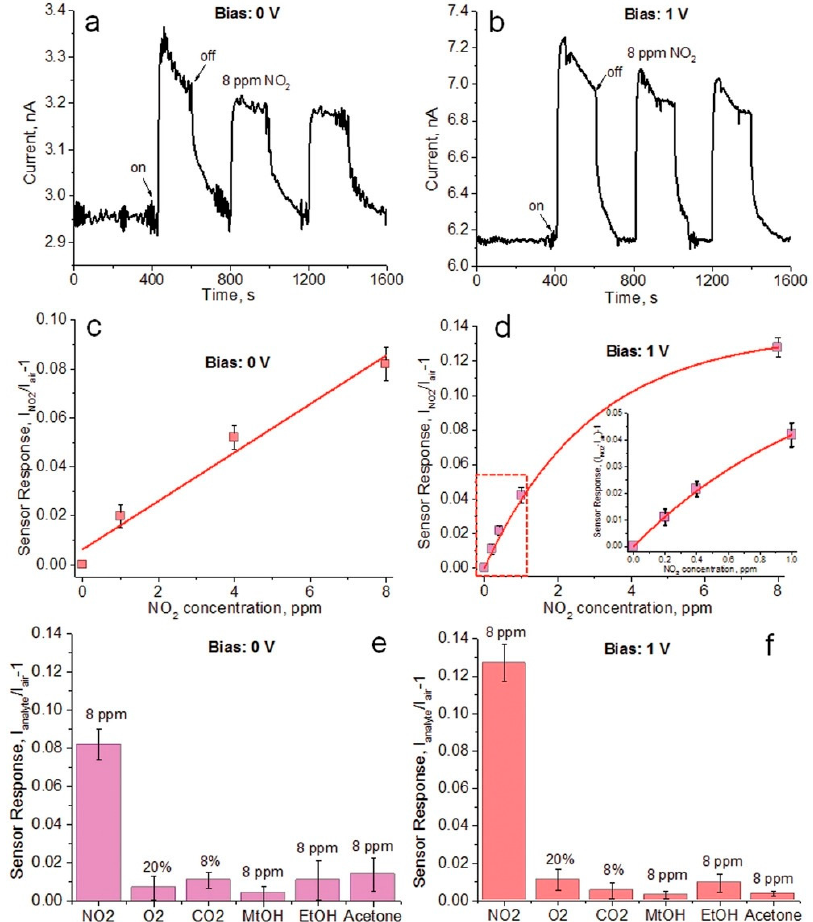
Figure 17. Room-temperature chemical response of the FMCPIB devices in the self- and externally-powered mode. Dynamic sensor response of an FMCPIB device to three consecutive injection of 8 ppm NO 2 ( a ) self-powered under weak fluorescent lamp light irradiation (1.3 µW cm − 2 ) and ( b ) externally powered with 1 V bias in the dark. FMCPIB sensor response as a function of the NO 2 concentration; ( c ) in the self-powered mode and ( d ) at the 1 V external bias; the inset in ( d ) is the enlarged part of the red dashed region. The sensor response of the FMCPIB sensor for six different gases ( e ) in the self-powered operational mode; and ( f ) at the 1 V external bias. The gas sensing measurements were conducted at room temperature (30 °C) under simulated air (V N 2 / V O2 = 4) with a constant total gas flow of 0.5 L min − 1 (reproduced with the permission from reference [166]).